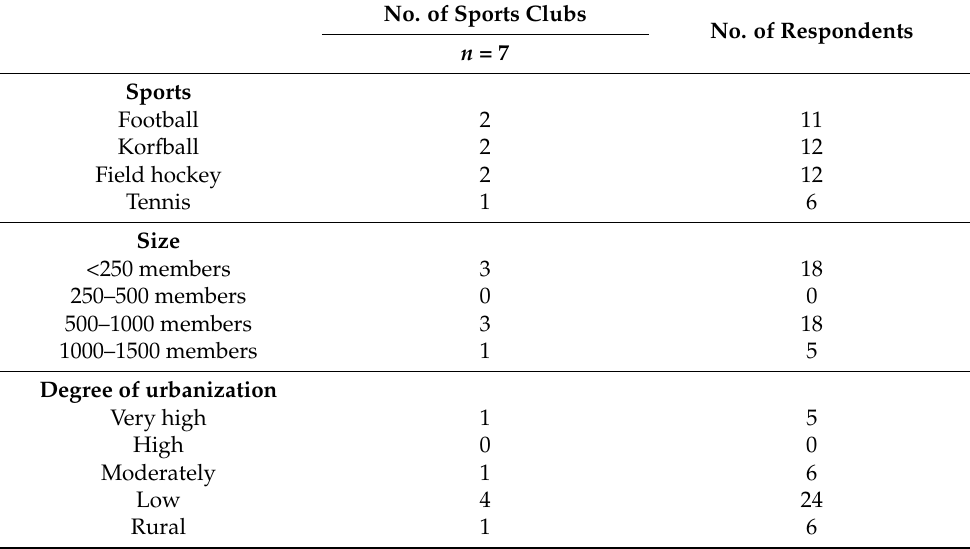
Table 1. Characteristics of the participating sports